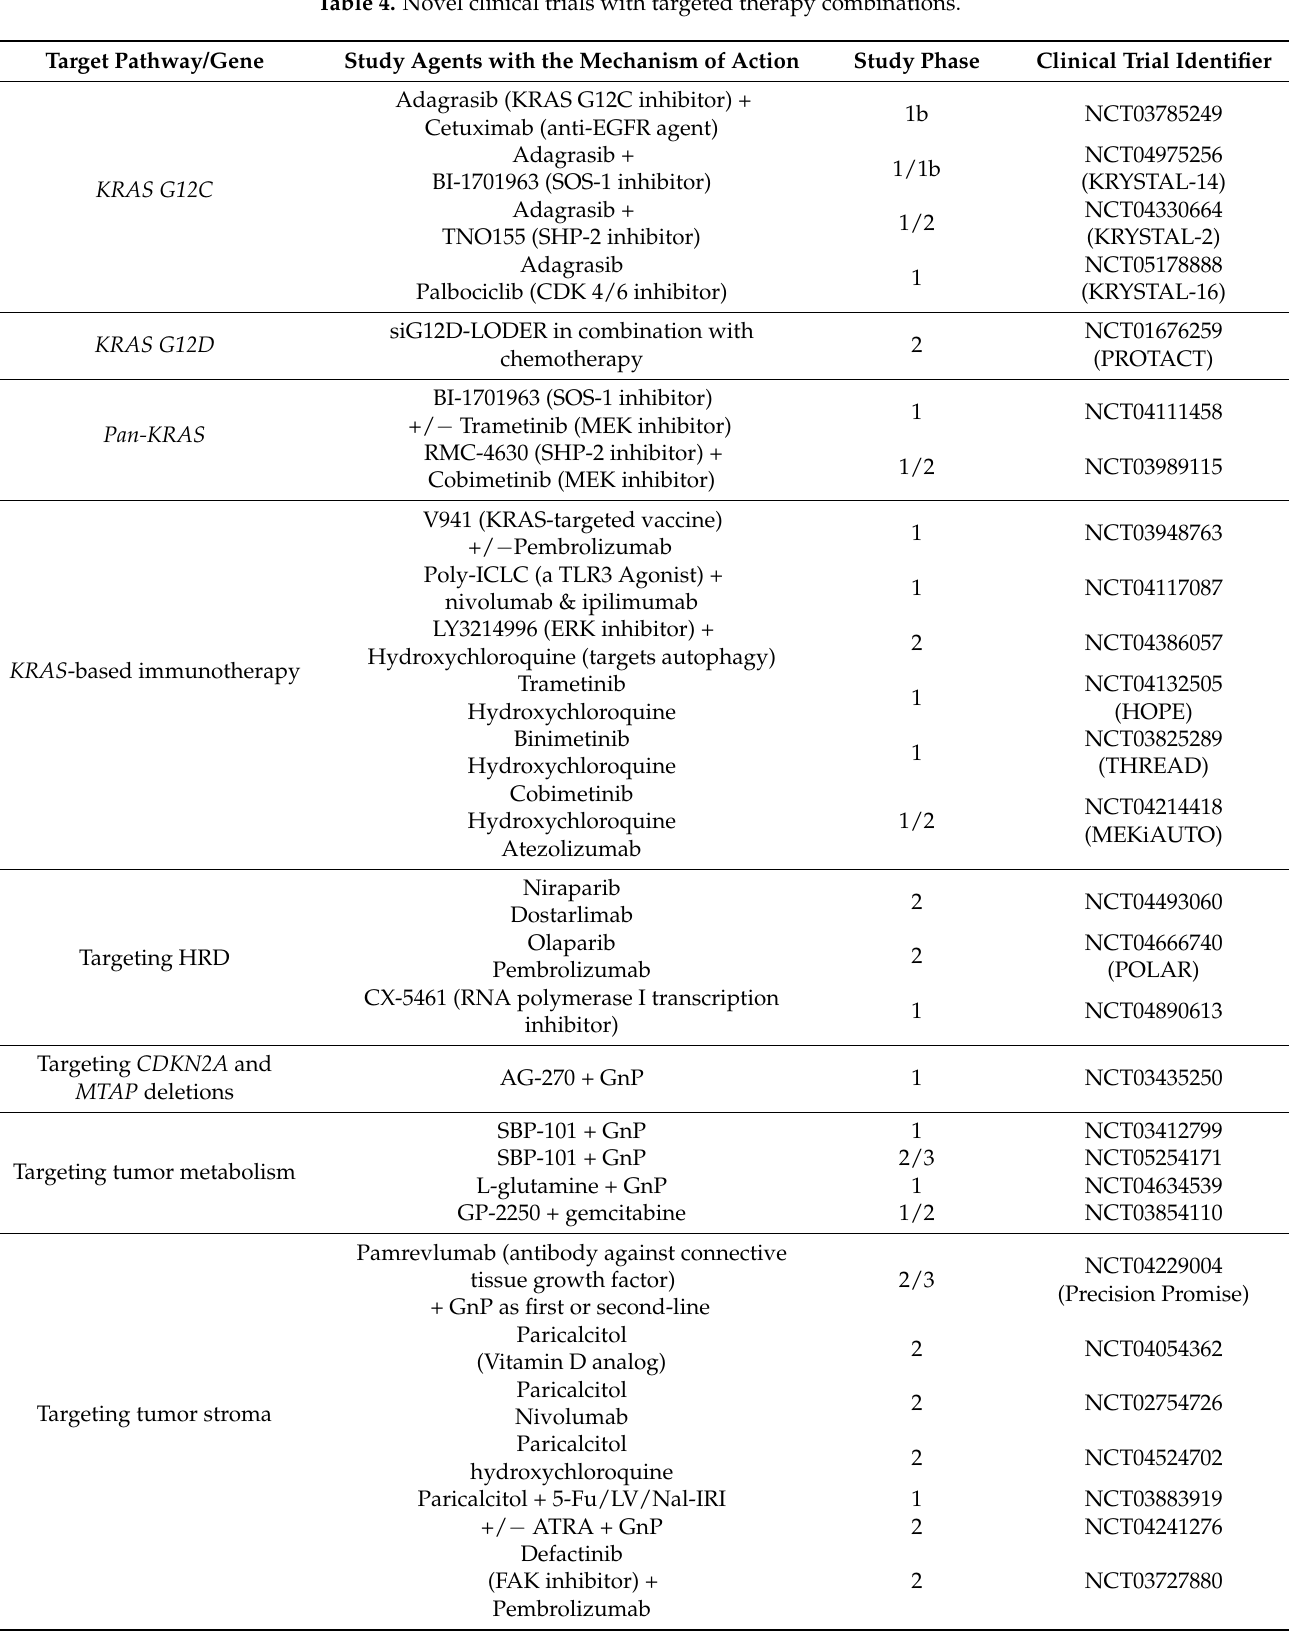
Table 4. Novel clinical trials with targeted therapy